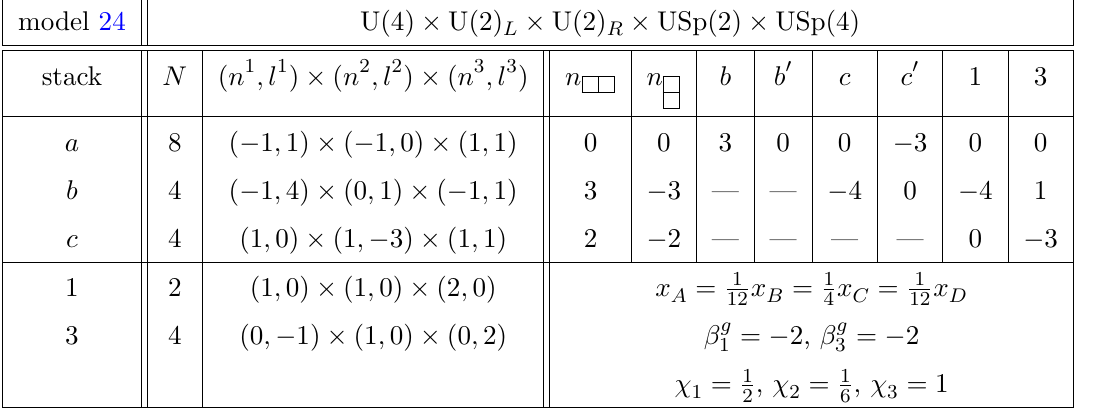
Table 24 . D6-brane configurations and intersection numbers of Model 24, and its MSSM gauge